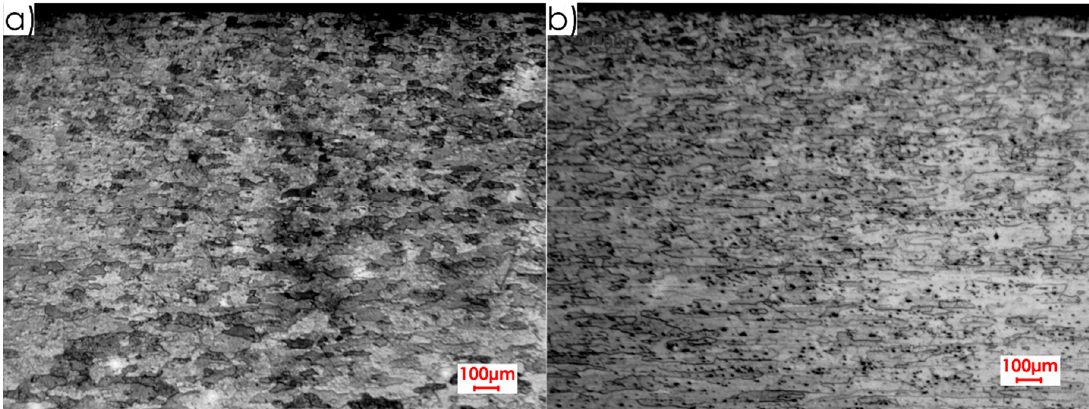
Figure 4. Microstructure of surface layer for EN AW-2024 T351 alloy: ( a ) perpendicular rolling direction, ( b ) parallel rolling direction (2.5× magnification).